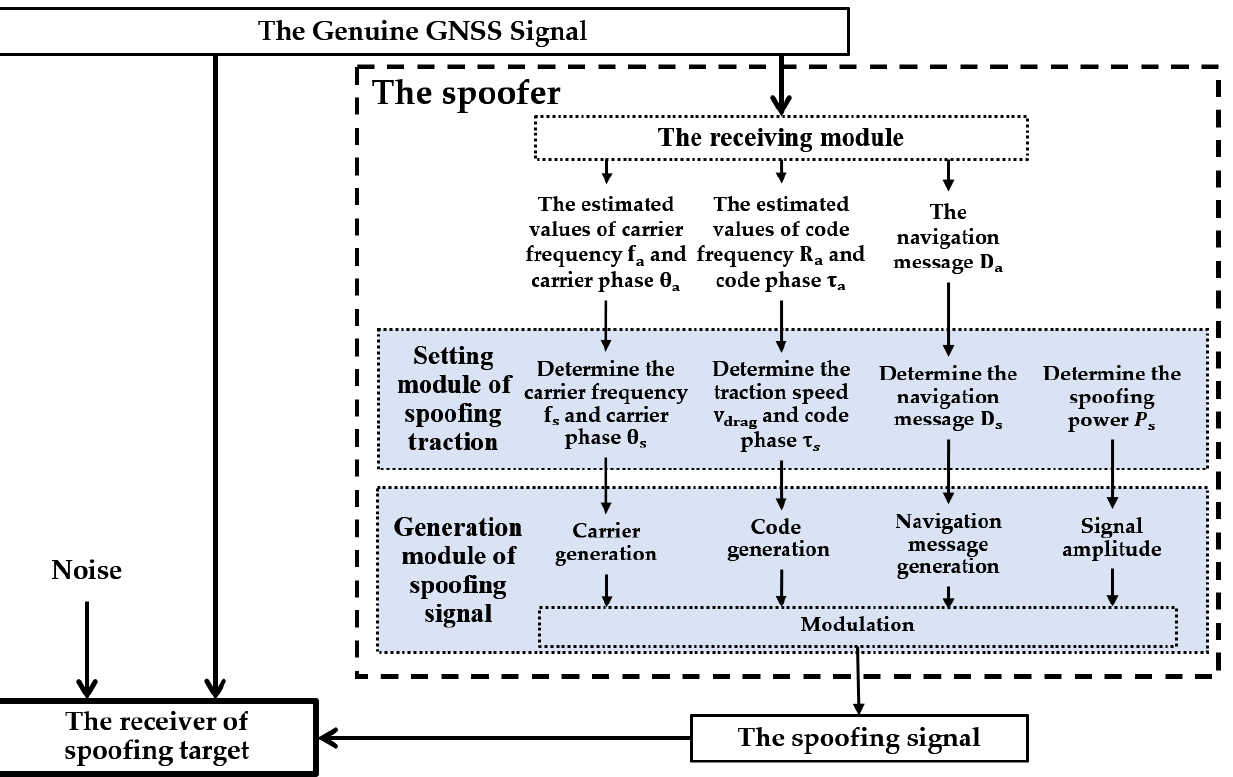
Figure 5. Schematic diagram of the deception process of the traction spoofer.